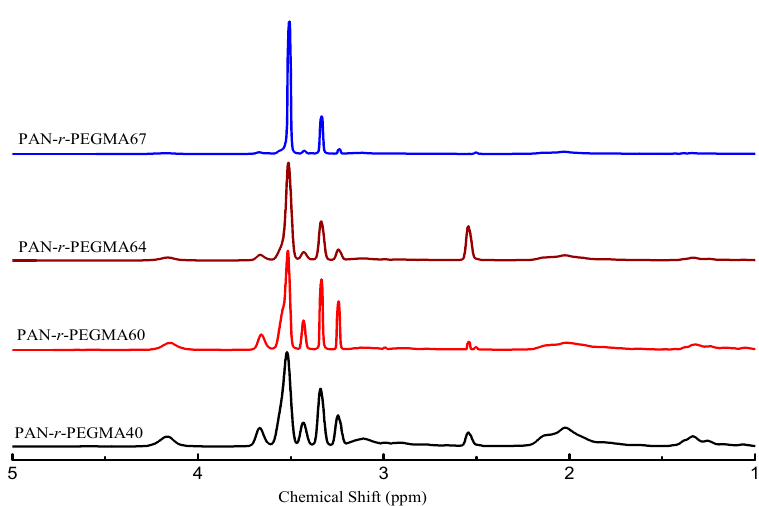
Figure 2. The 1 H-NMR spectra for PAN- r -PEGMA copolymers in DMSO-d 6 solvent.